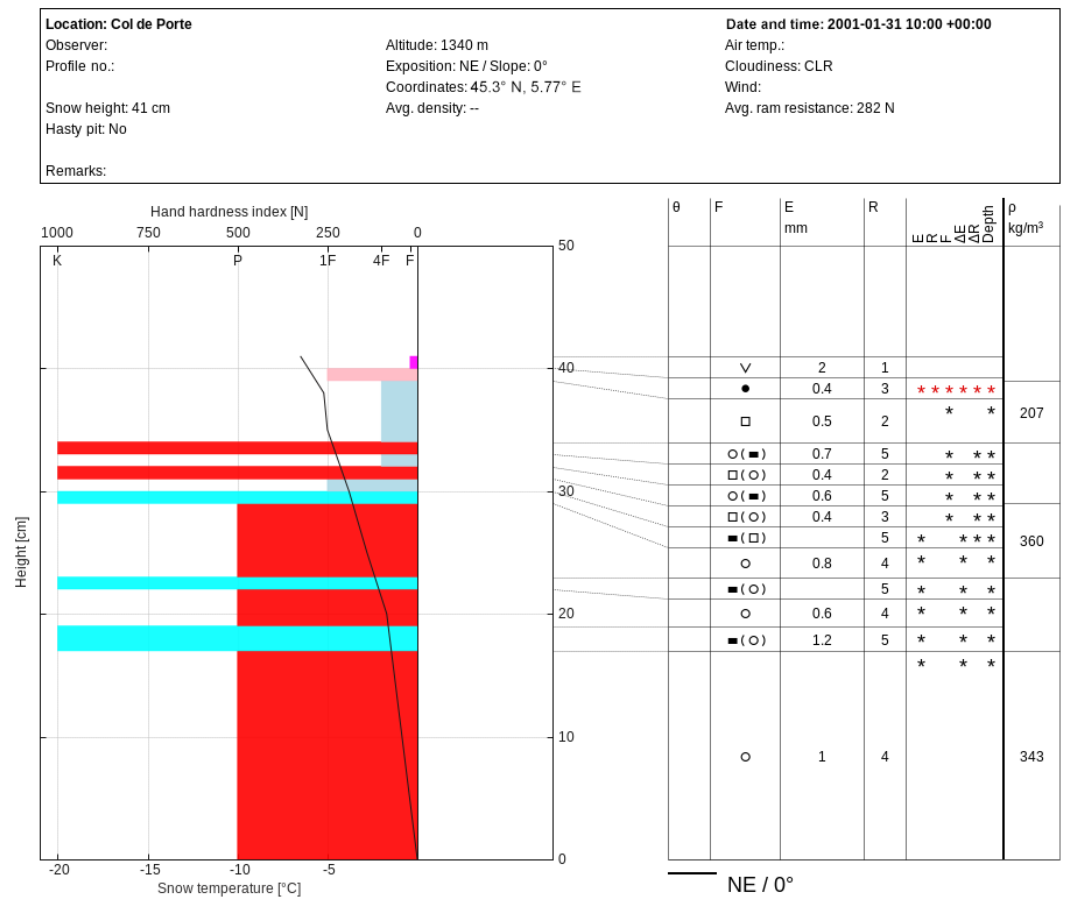
Figure 6. Example of the snow profile measured on 13 January 2001, visualized using Niviz software.